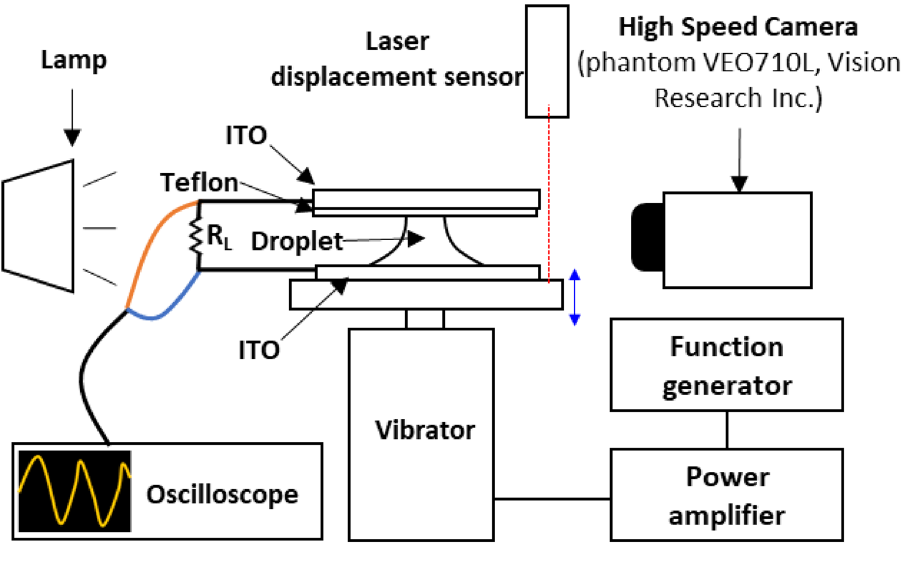
Figure 1. Diagram of experimental